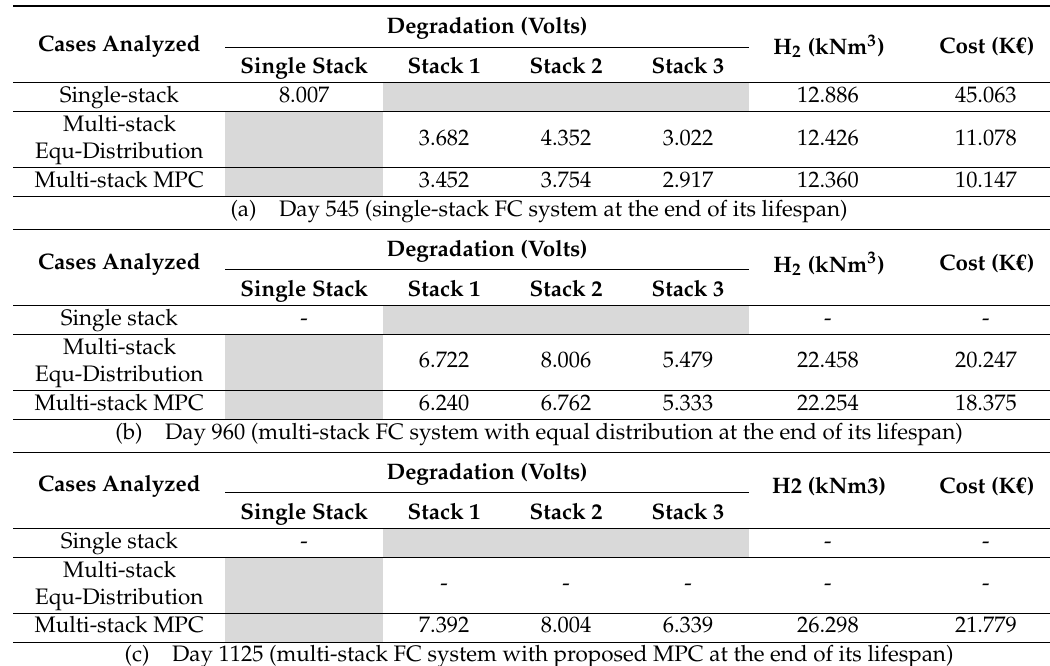
Figure 7. Operating costs of the FC system in the three cases (single-stack FC system, multi-stack FC system with equal power distribution, and multi-stack FC system with MPC controller) (1 k€ = 10 3 €). Table 5. Simulation